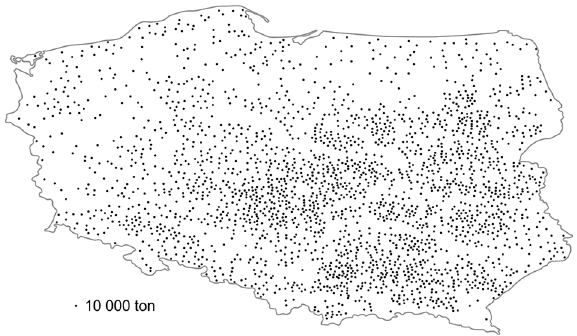
Fig. 1. Incorrectly chosen cartographic projection for the map of potato harvest in Poland results in distortion of spatial relations (on the basis of a map in the online Atlas of cartographical presentation methods ,